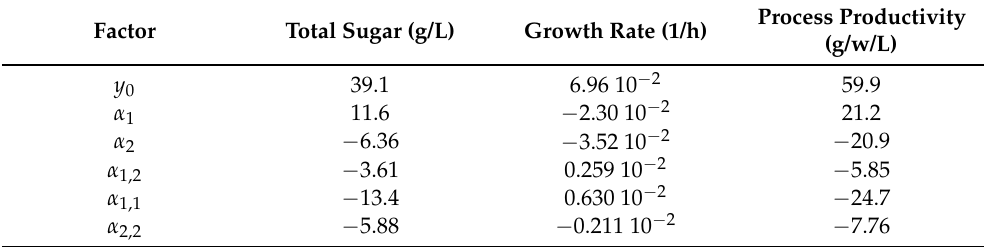
Table 6. Coefficients for the response surfaces. Variables should be specified in coded units.